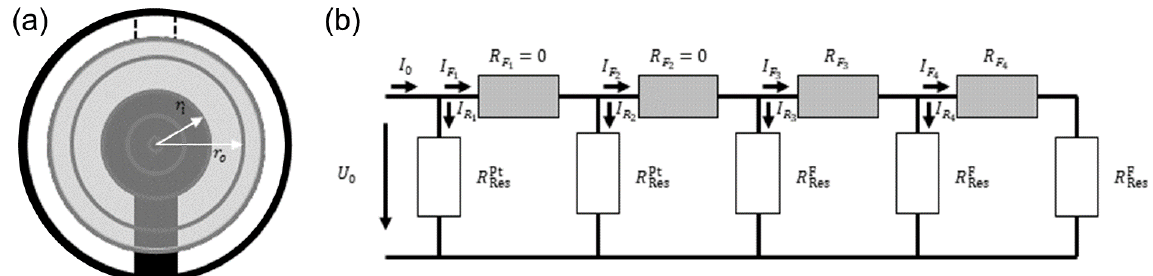
Figure 2. Model for the calculation of effective resonator radius. (a) Distribution of the electrode sections. Only five sections (inner cir- cular section and four rings) are shown to visualize the model. The inner sections reflect the Pt electrode, and the corresponding electrical resistances are set to zero. The other sections represent the oxide electrode area, and the resistance can be determined using Eq. (16). (b) Cor- responding electrical circuit. Again, four electrode sections ( R F five underlying sections (one inner circular section and four rings) are denoted as R Pt